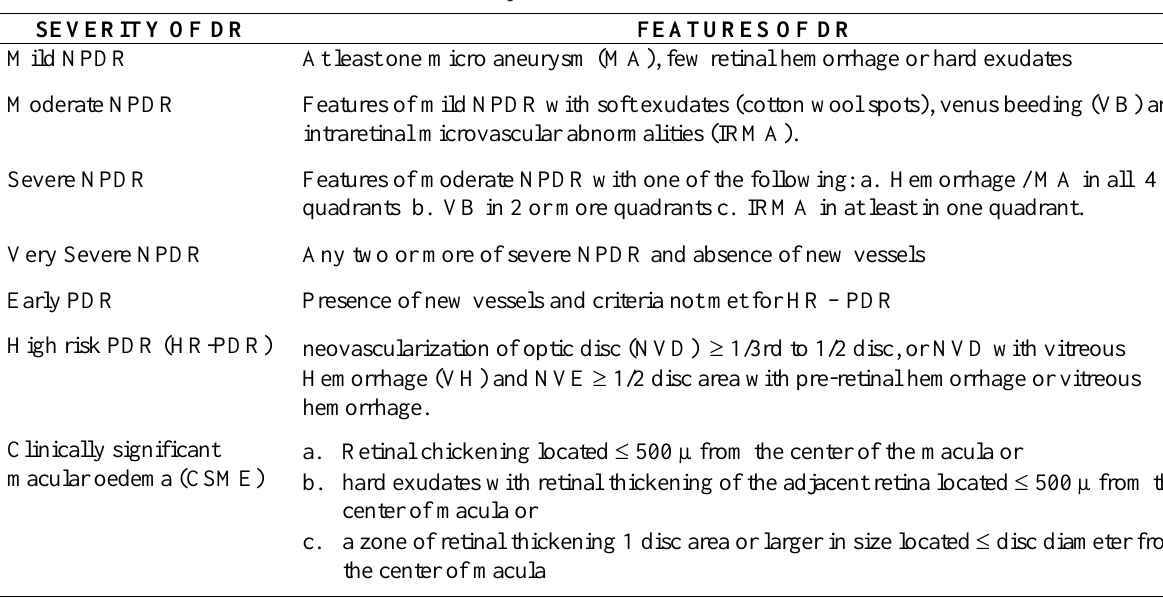
Table I : Severity of DR and its Fundus